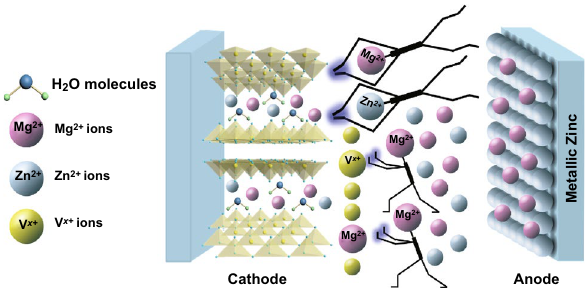
Fig. 6 Scheme of the Mg 2+ functional mechanism for hybrid electro-